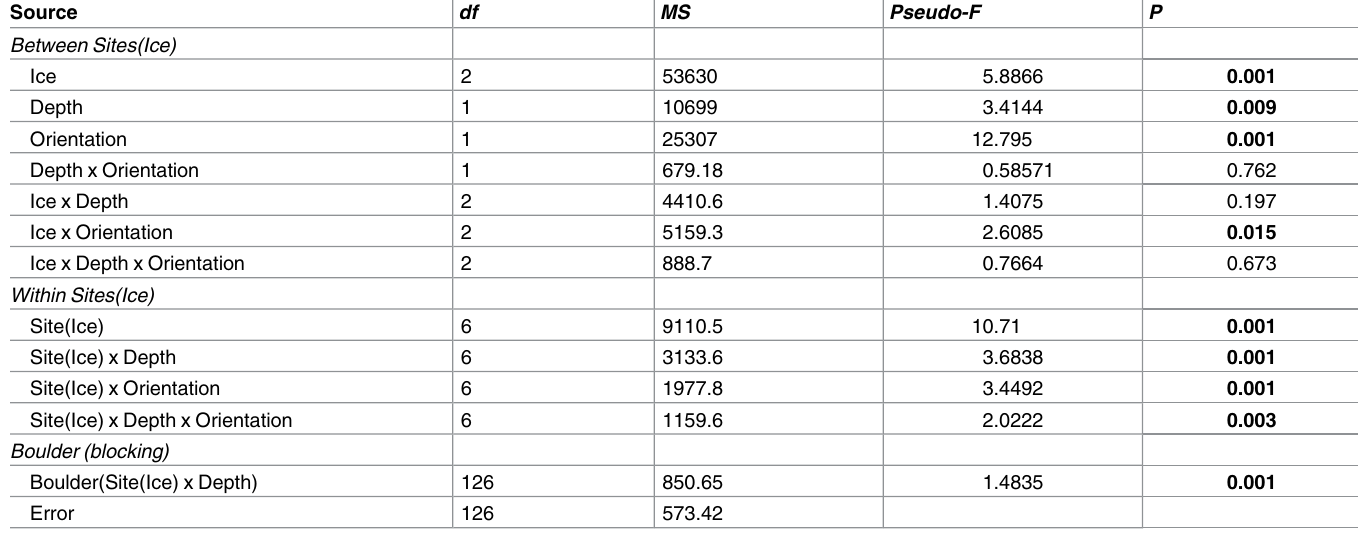
Table 3. Permutational multivariate analysis of variance(PERMANOVA) testing for differences in community structure with respect to ice cover, depth and orientation. Significantdifferences ( P < 0.05) are denotedin bold. Data are fourth-root transformed, and distances were based on the Bray-Curtis similarity